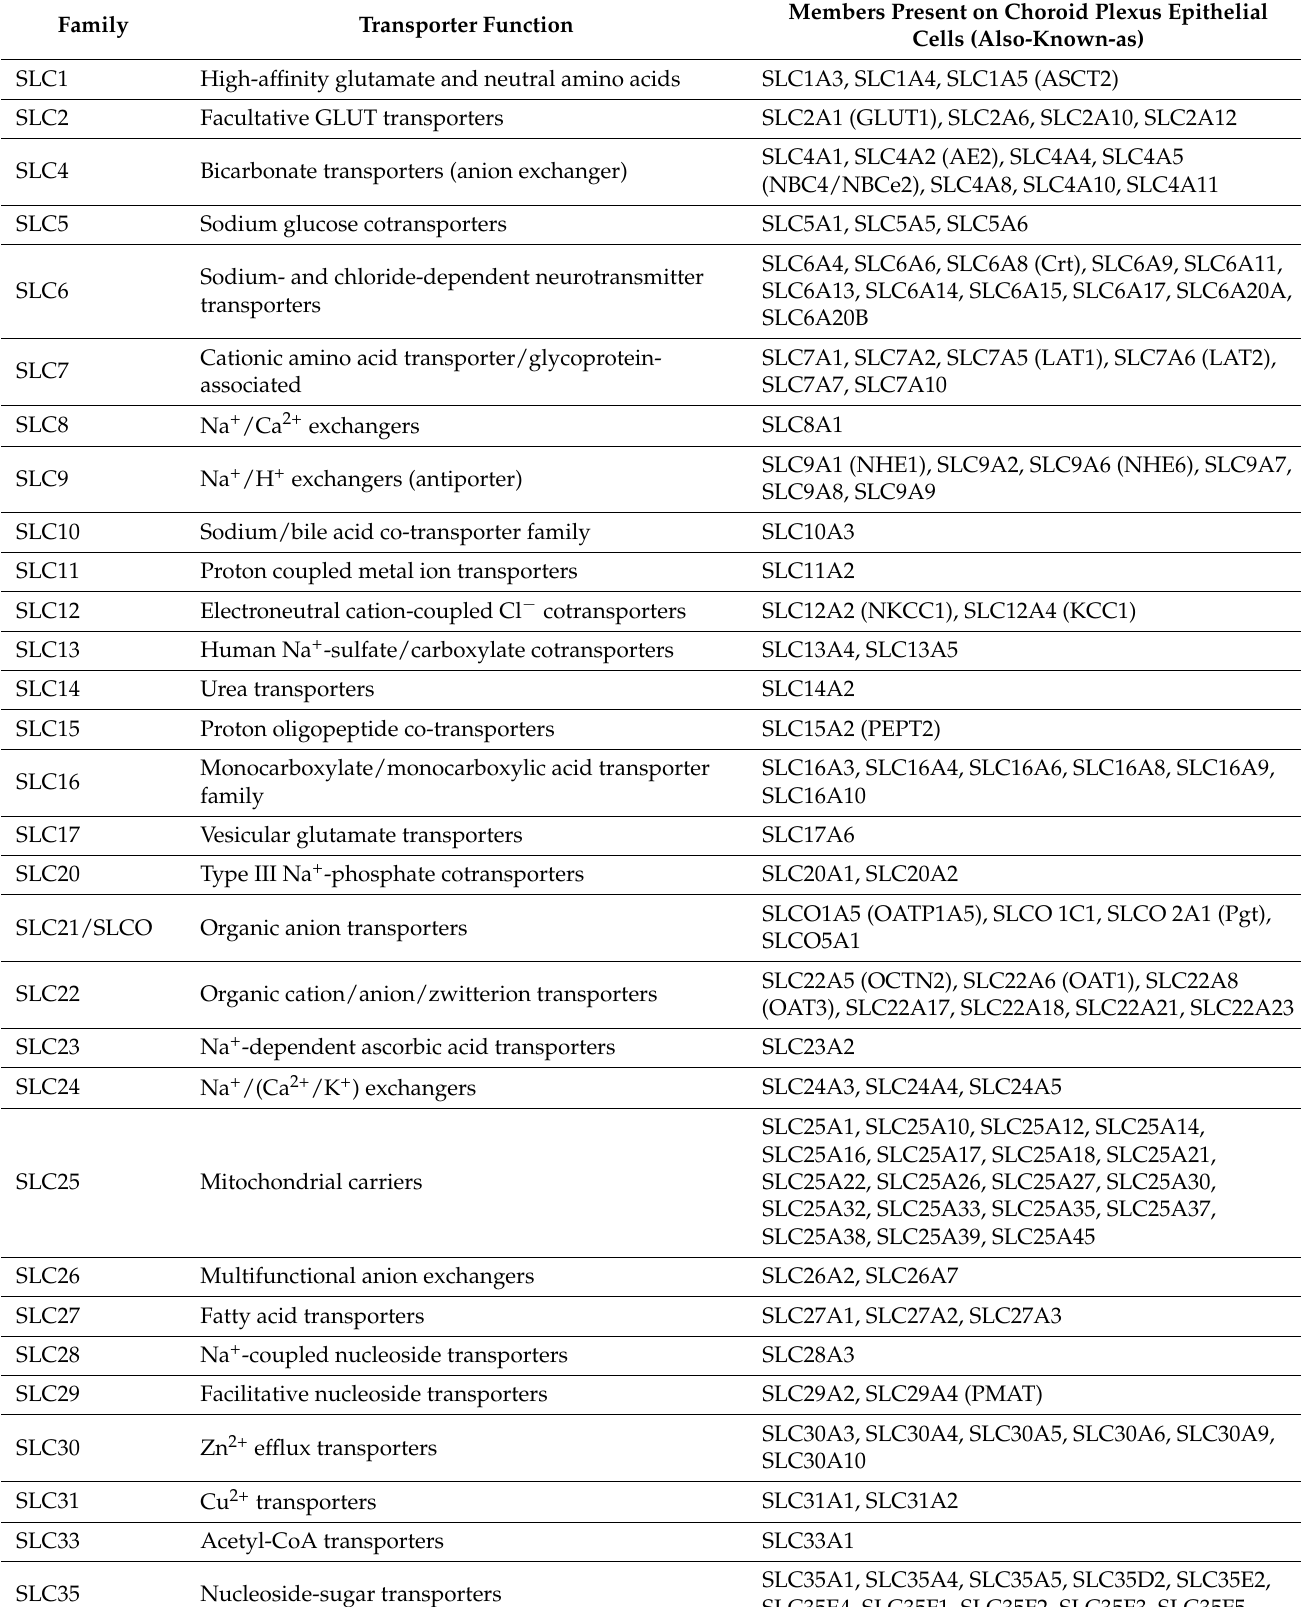
Table 1. Transporters at the